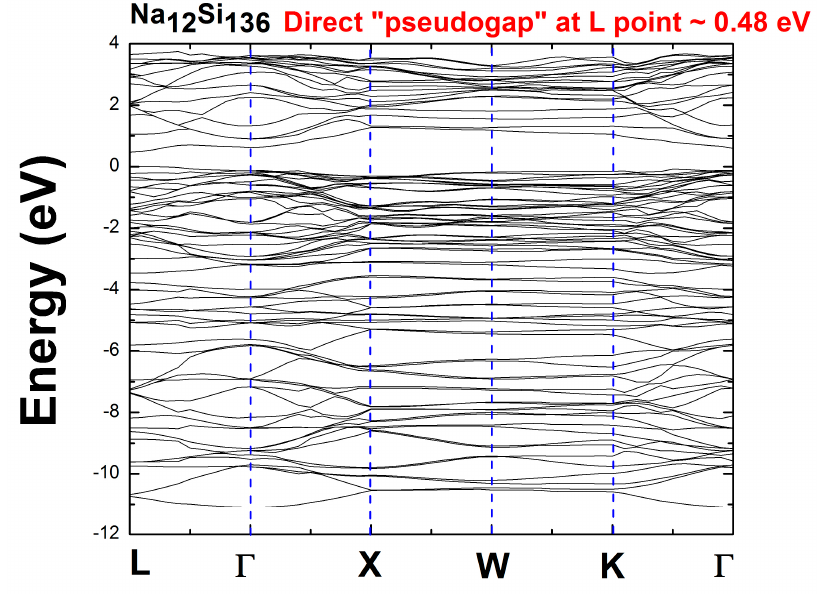
Figure 2. Electronic band structure of Na 12 Si 136 .